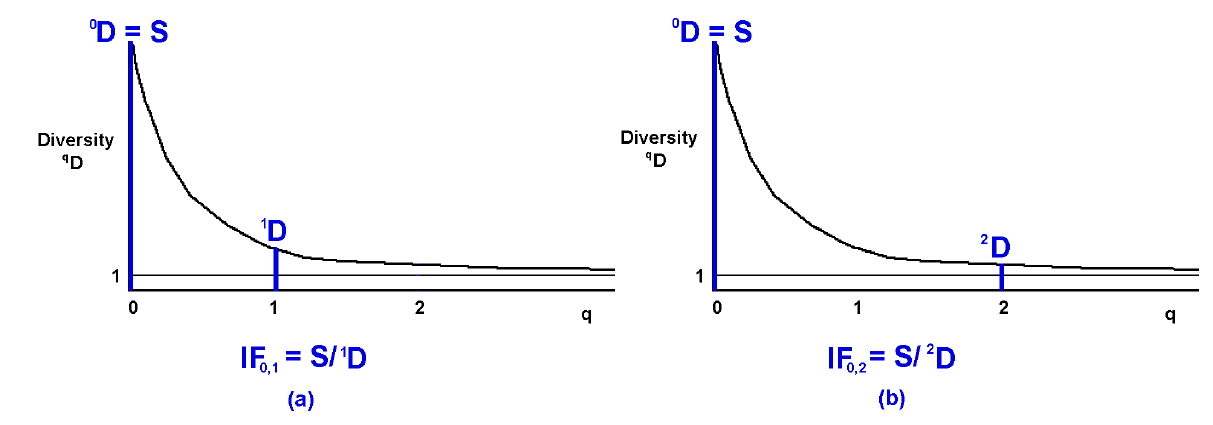
Figure 2. Inequality factors in relation to the diversity profile. The y-axis is diversity of order q, and the x-axis is the order q. IF is the ratio of the two distances shown in blue on 0,1 the left. IF is the ratio of the two distances shown in blue on the 0,2